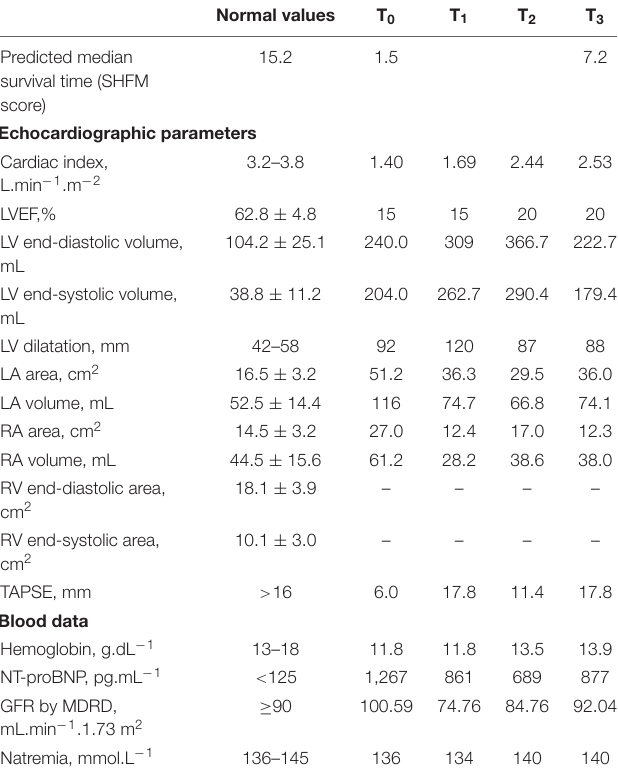
TABLE 1 | Changes in renal function and resting cardiac parameters induced by the ECR